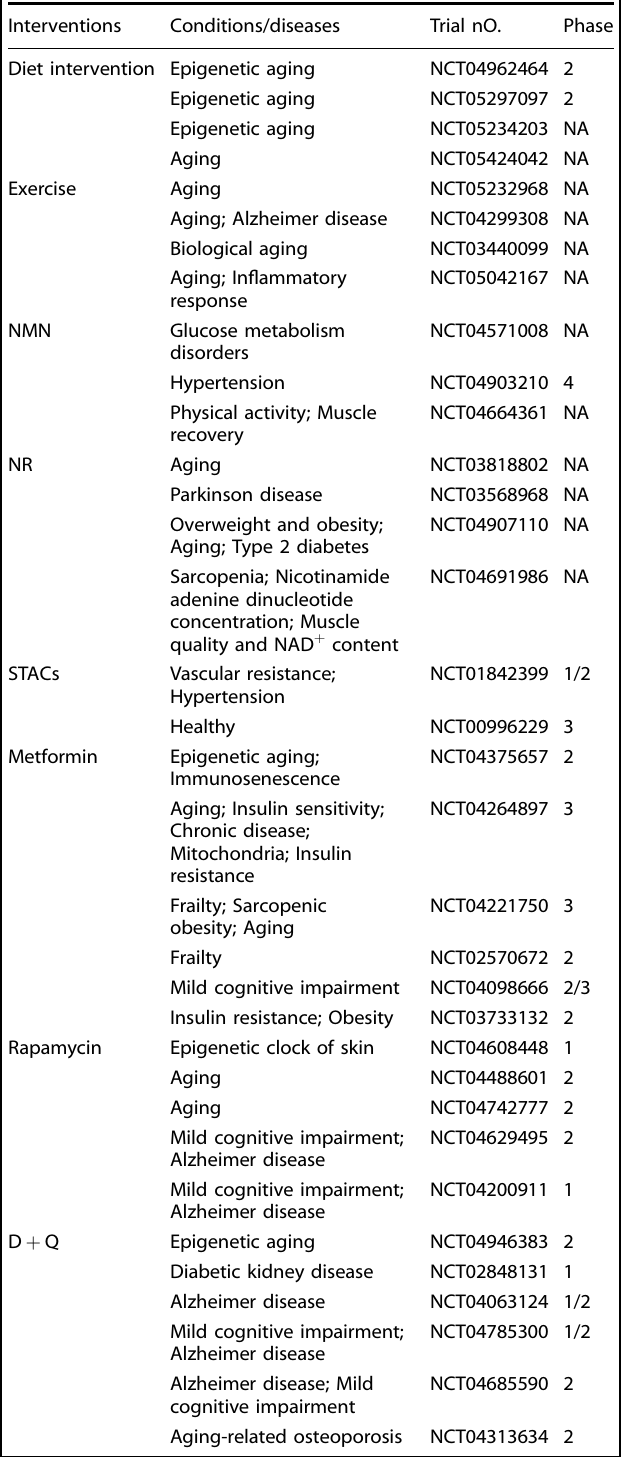
Table 1. Ongoing clinical trials related to epigenetic targets